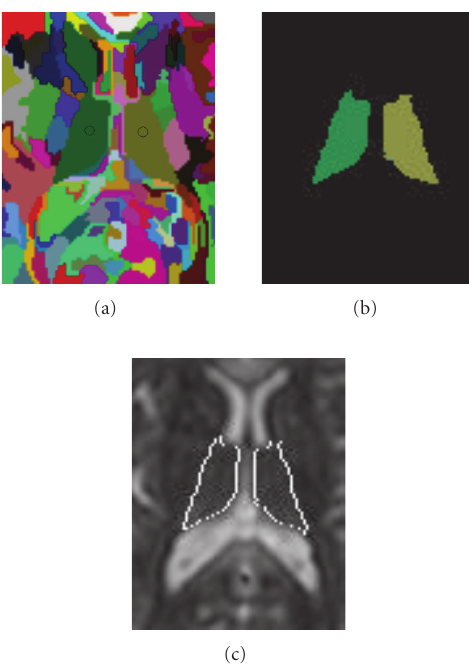
Figure 1: Thalamus segmentation. (a) The initial thalamus seg- mentation is conducted interactively, that is, the user need to iden- tify the pair of symmetric clusters (left thalamus and right thalamus, marked by circles in the figure for illustration) from other clusters. Since the thalamus is bounded by relatively homogenous structures such as the fiber tract and Cerebrospinal fluid (CSF), this step can be done quite easily. (b) Extracted pair of thalamus. (c) Extracted pair of thalamus superimposed on the original DT-MRI